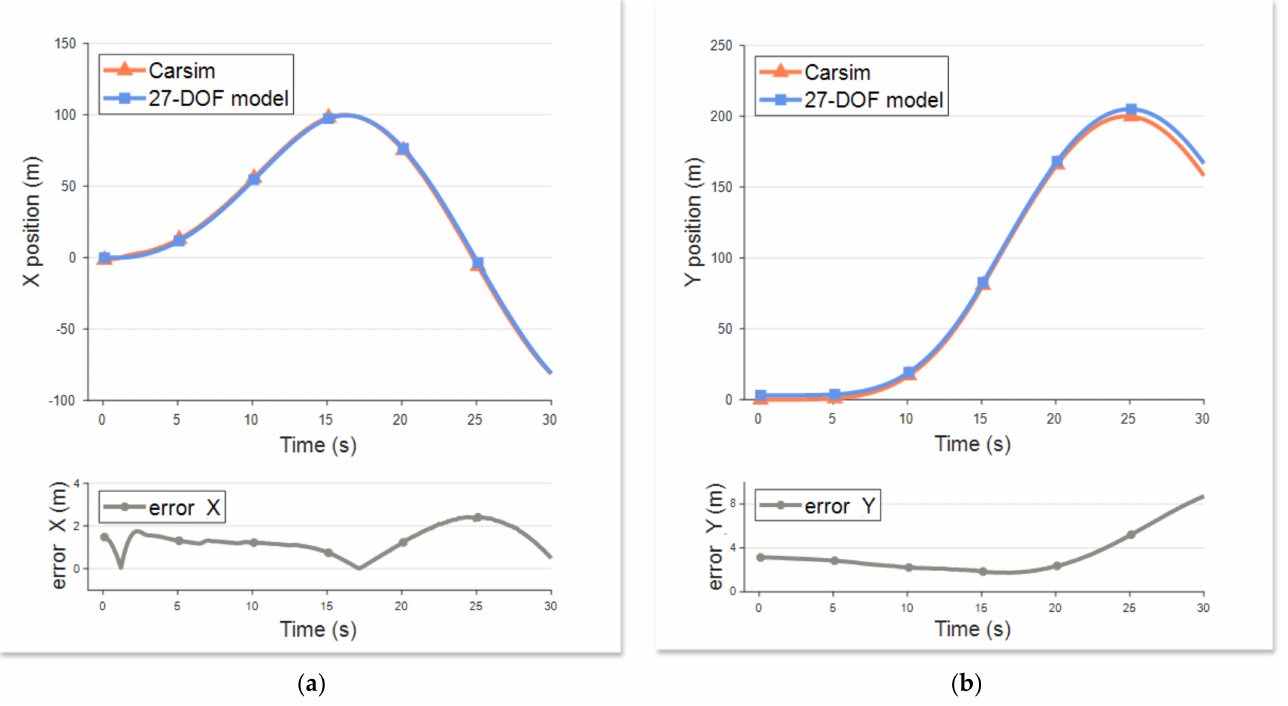
Figure 7. Vehicle position of the 27-DOF model and CarSim in the Const Radius Scenario of speed = 55 km/h and radius = 100 m. ( a ) X Position. ( b ) Y